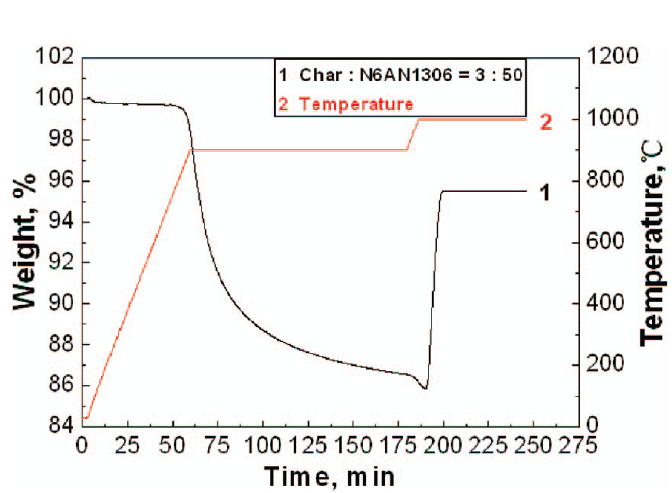
Figure 4. Weight change (TG) of single cycle reduction-oxidation reactions of coal char and NiO/NiAl 2 O 4 oxygen carriers